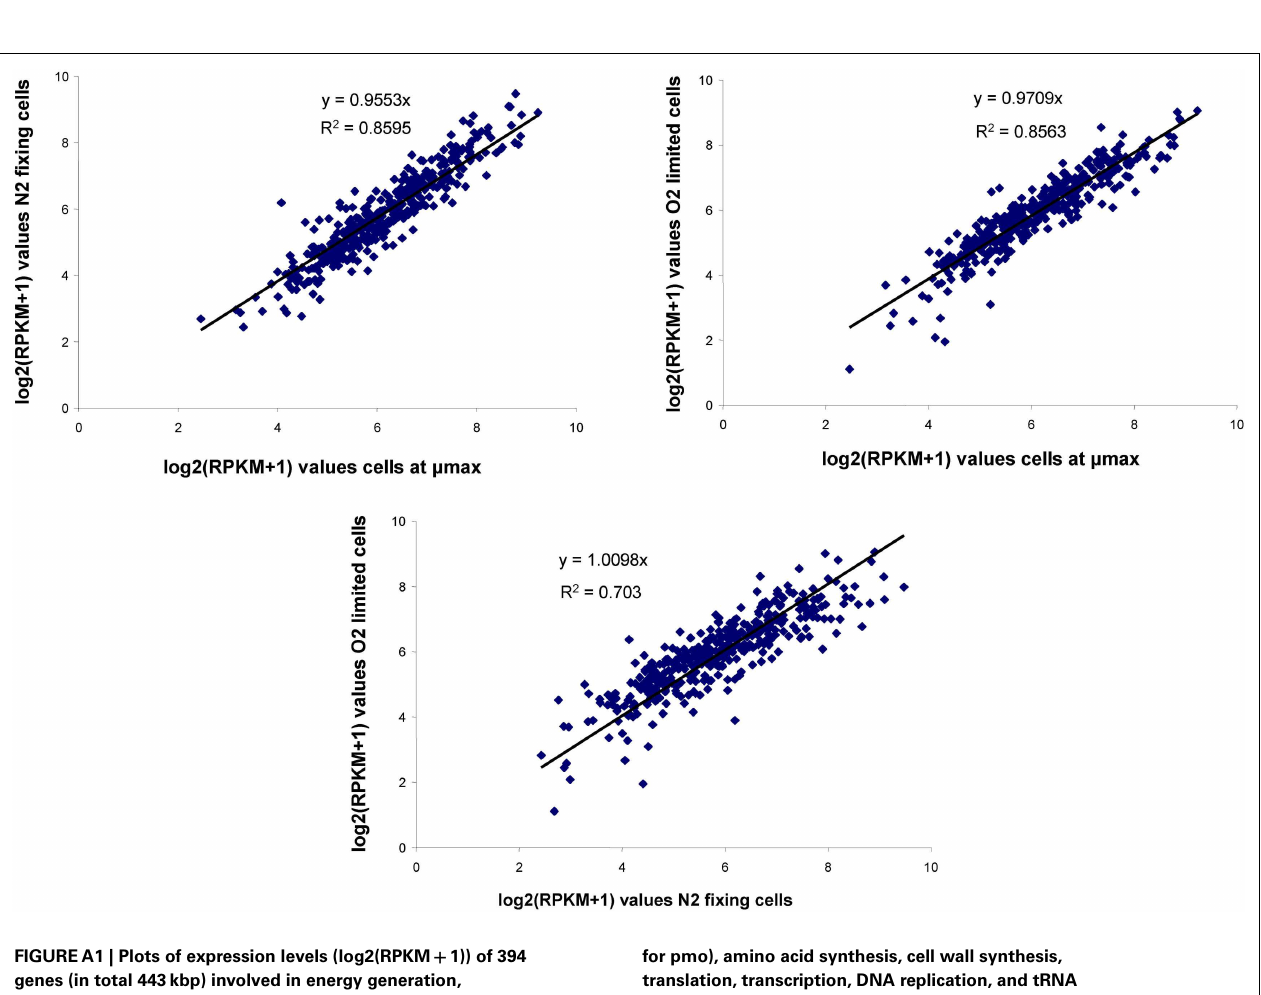
FIGUREA1 | Plots of expression levels (log2(RPKM + 1)) of 394 genes (in total 443kbp) involved in energy generation, ribosomes, carbon fixation (CBB cycle), Cl metabolism (except